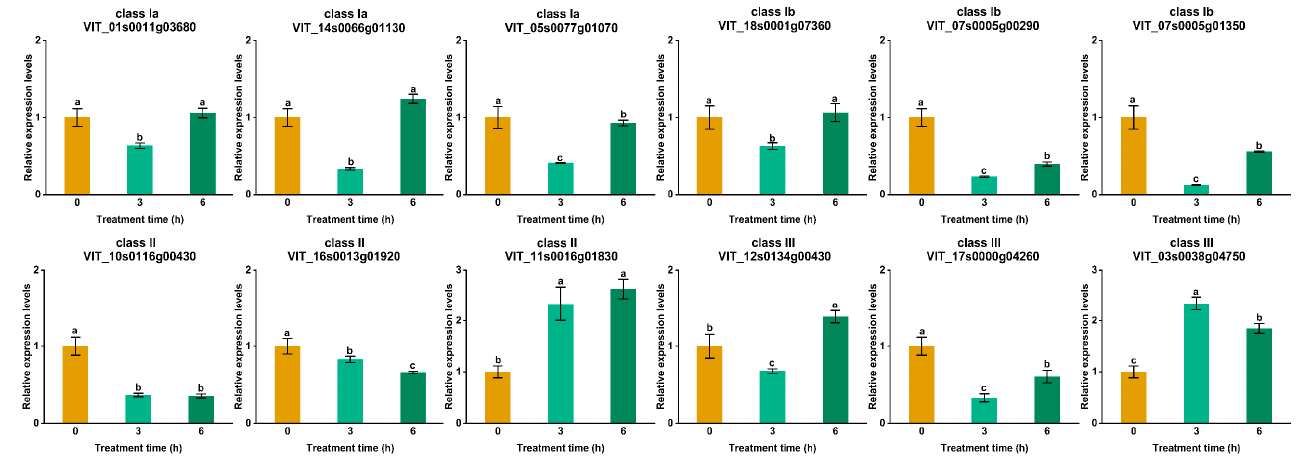
Figure 9. Expression levels of VvUSP genes under heat-stress treatments by qRT-PCR. Different letters above the bars indicate a significant difference ( p <